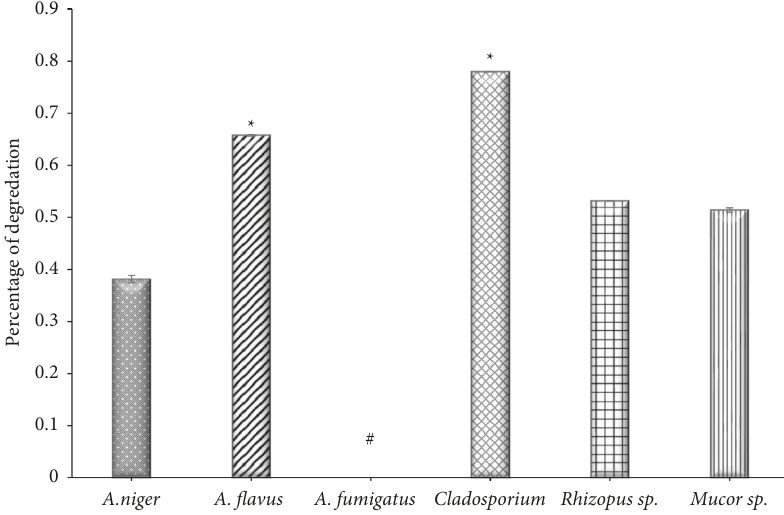
Figure 1: The activity of amylase of endophytic fungi isolated from Ziziphus spina leaves on solid medium. ∗ Significant difference with ( A. niger , (A) f umigatus, Rhizopus sp., And Mucor sp. ), at P < 0 . 001. # Significant difference with all other groups at P < 0 .